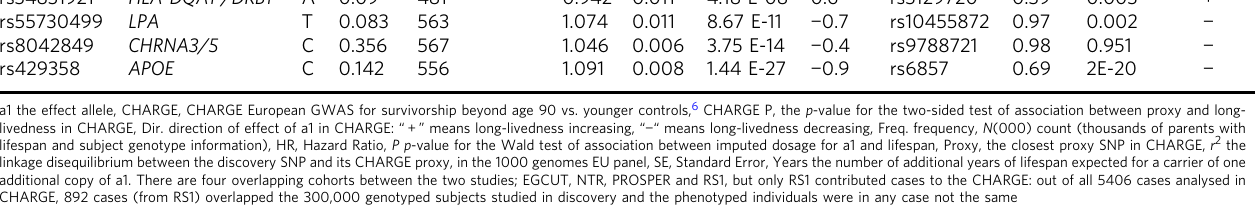
Table 2 Four regions associated with lifespan at genome-wide signi fi cance and replication via proxy SNPs in CHARGE rsid